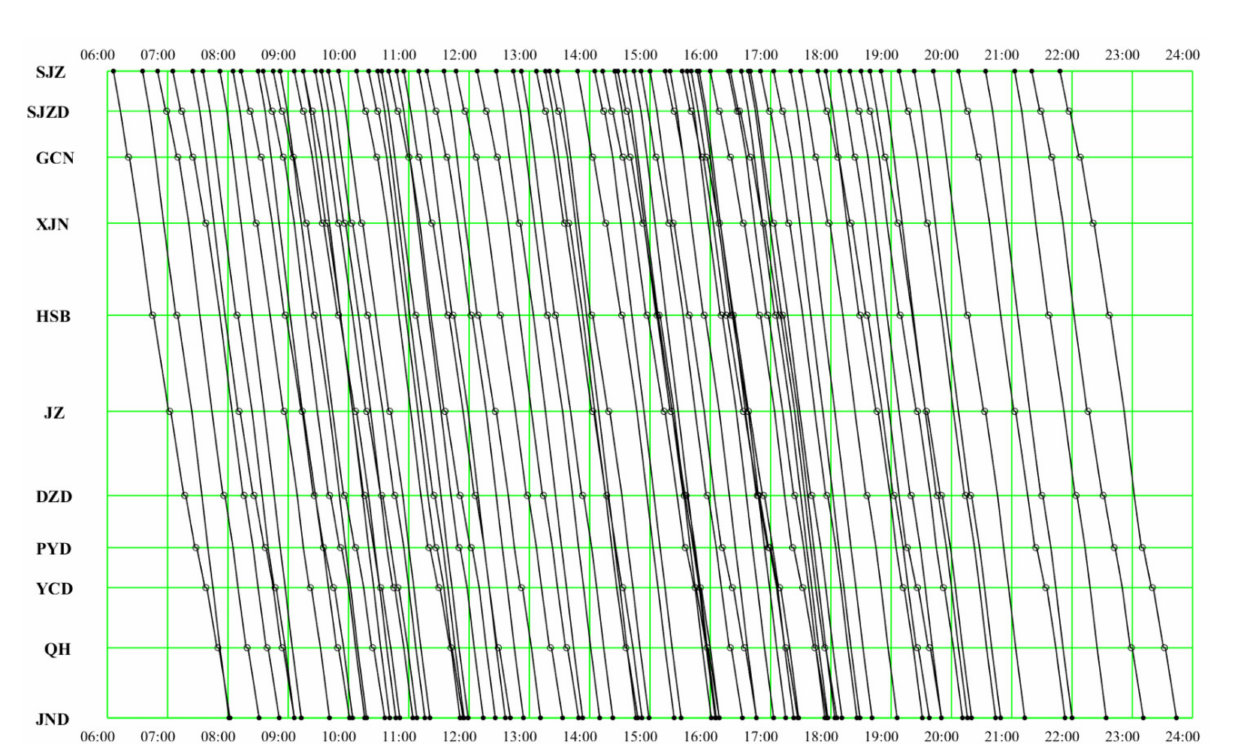
Figure 9. The train plan of Shi-Ji high-speed railway in the downward